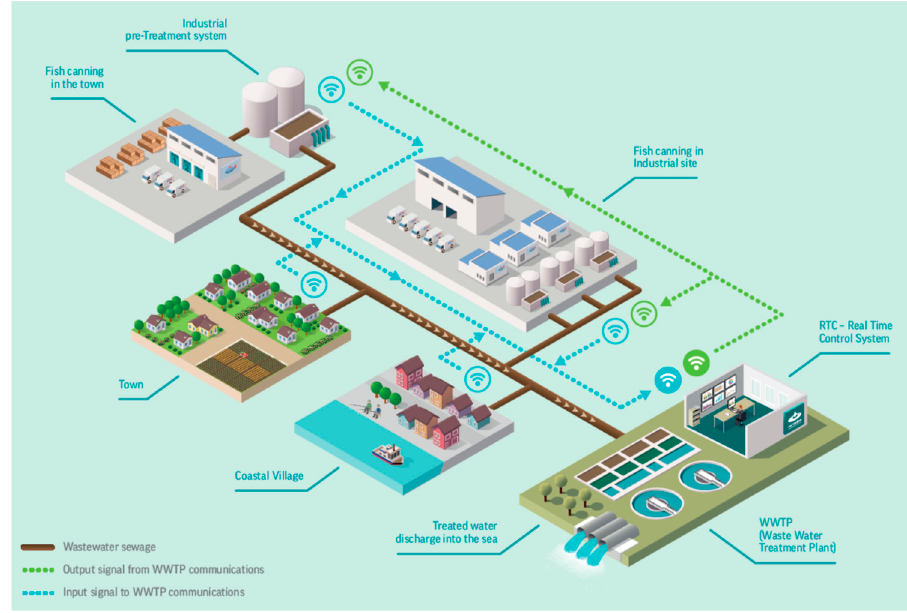
Figure 1. VERTALIM project schema: controlled integration of industrial wastewaters into the urban sanitation system.